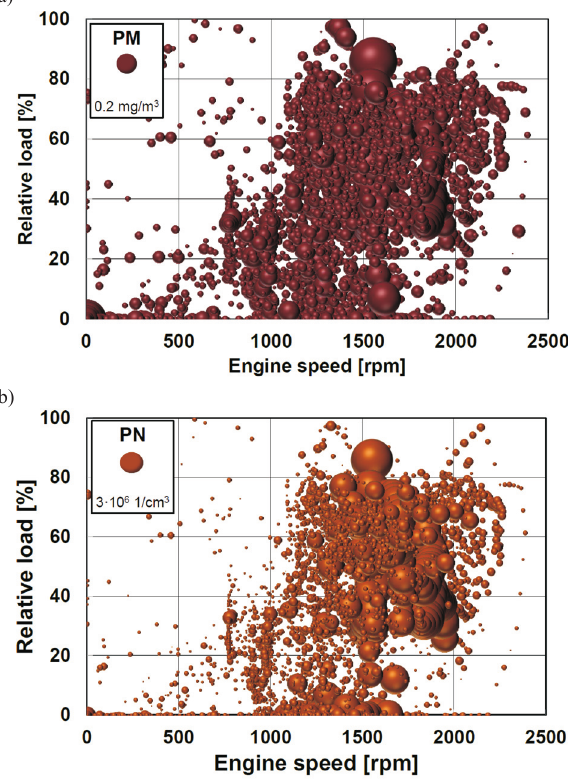
Fig. 6. Emission intensity by mass (a) and the number (b) of particles related to engine operating parameters during the RDE vehicle test (diesel engine)